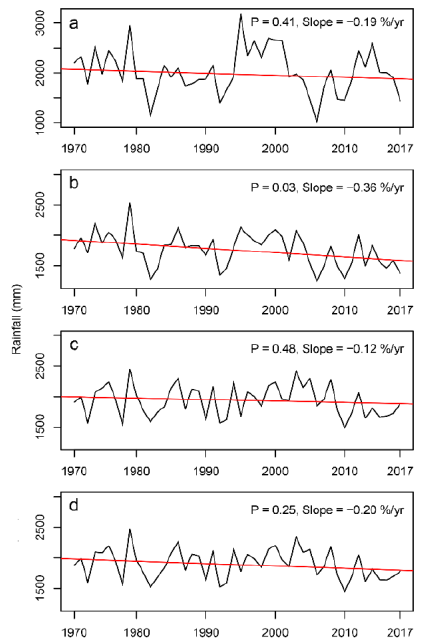
Figure 3. Long-term trend in annual average rainfall of ( a ) headwater, ( b ) upper, ( c ) middle and ( d ) entire Bagmati catchments. Decadal analysis of rainfall departures from the long-term mean (Figure 4) shows that regional average rainfall in the catchment was higher to substantially higher than the long-term mean during the 1970s. On the other hand, rainfall after 2010 was substantially lower in all parts of the catchment except the headwater catchment. Patterns of decadal average rainfall in middle and entire catchment were very similar, with minor departures from long-term mean and the departure after 2010 being substantial in both cases. Decadal departure of rainfall in headwater catchment highly fluctuated, while the departure in the upper catchment showed generally decreasing rainfall during 1970 – 2017.